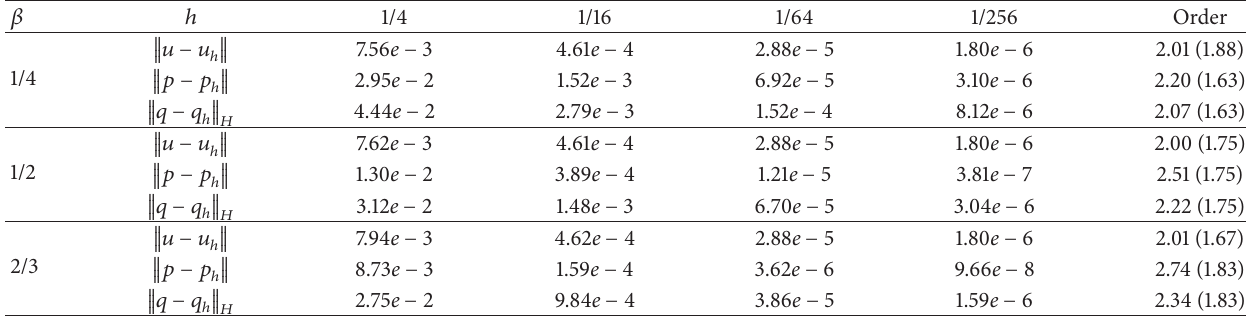
Table 2: Numerical result of Example 1 on a uniform mesh of size ℎ for 𝑘 = 2